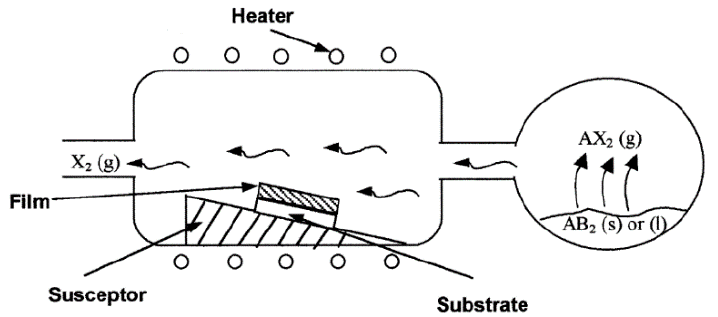
Figure 4. Schematic diagram of chemical vapor deposition (CVD) deposition system [38]. Reprinted with permission from [38]; 2003 Elsevier.